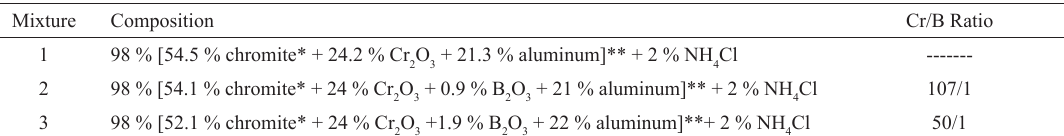
Table 1: Mixture composition.